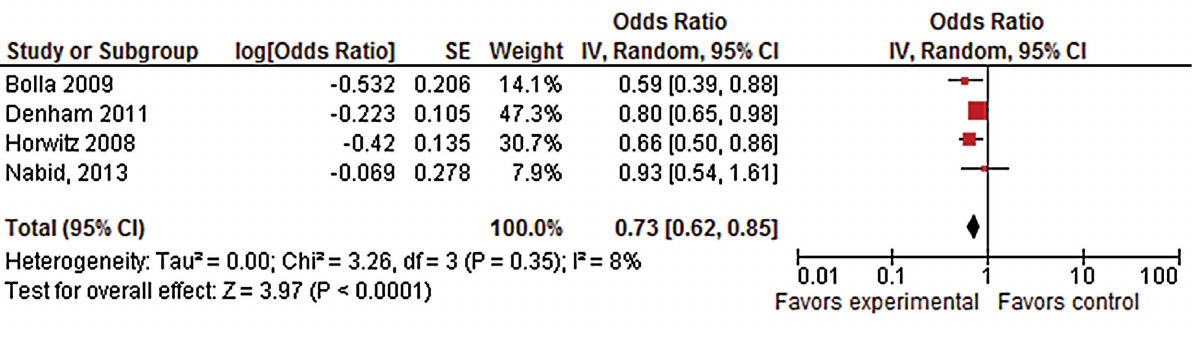
Figure 4 - Disease-specific Survival – Pooled